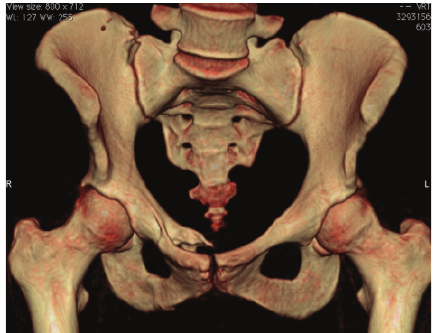
Figure 2: Intraoperative photographs from cystoscopy demonstrat- ing a spike of bone in the bladder.